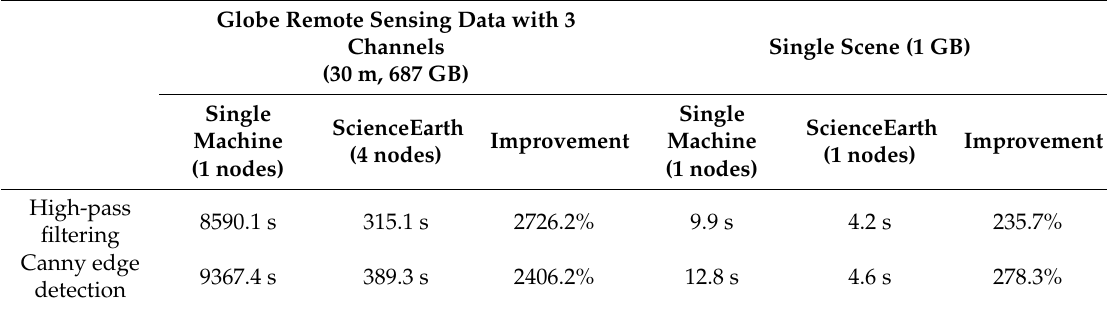
Table 3. Comparison of e ffi ciency with ScienceEarth and a normal server. Globe Remote Sensing Data with